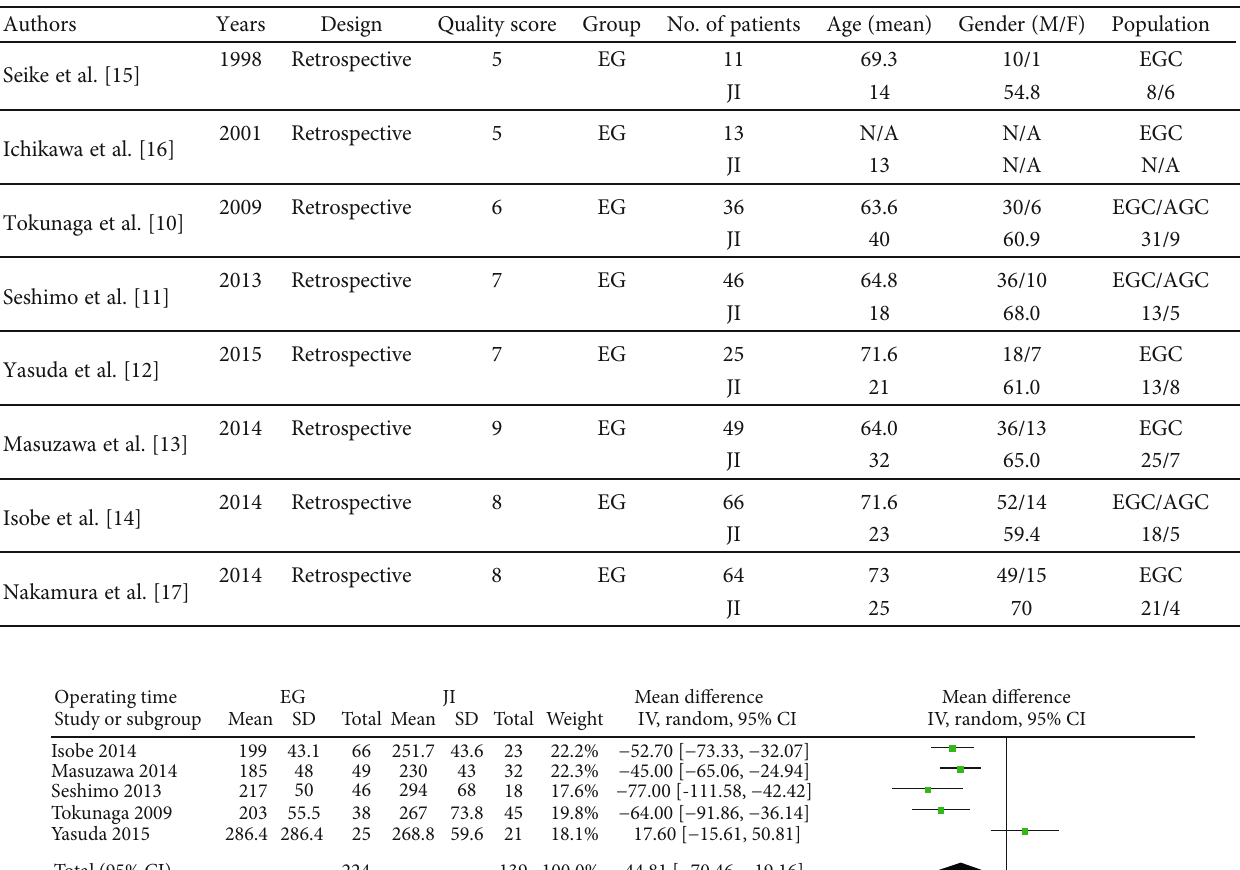
Table 1: Clinical characteristic of the included studies in meta-analysis.